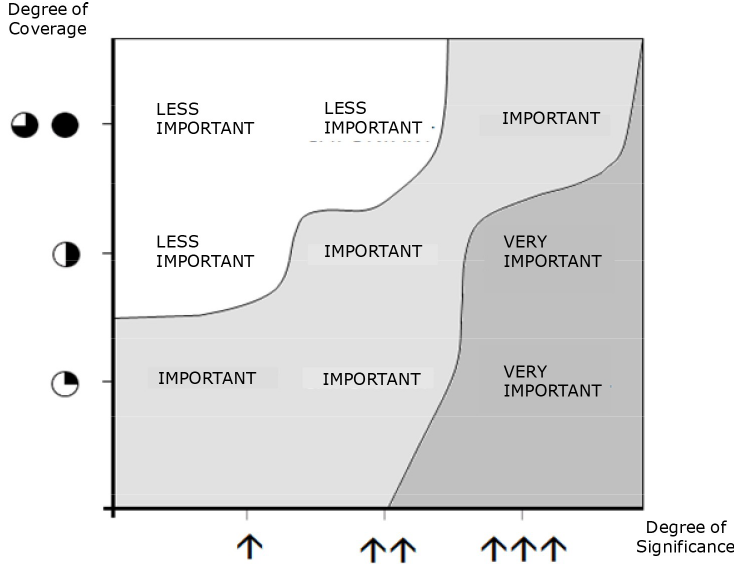
Figure 2. Areas of importance solution degree